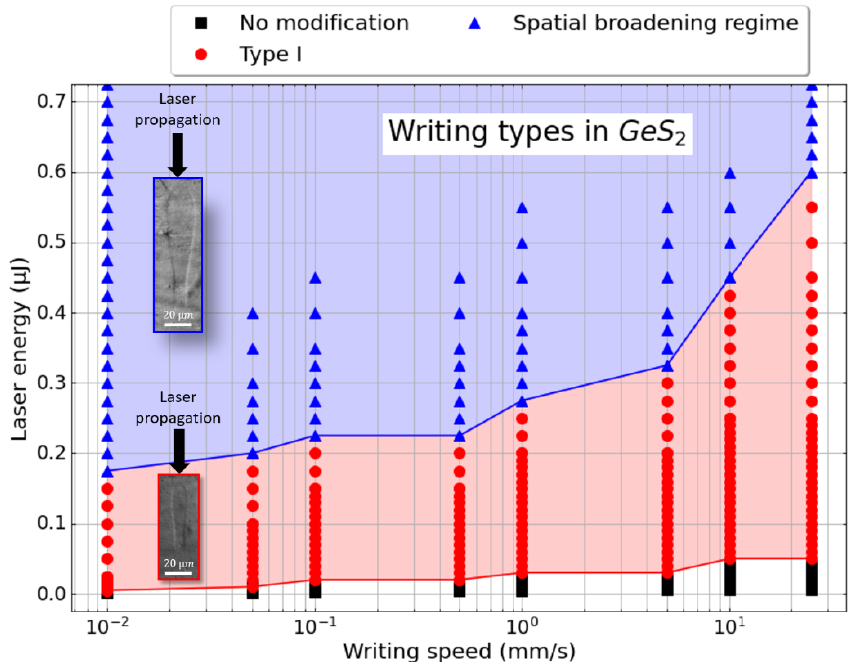
Figure 6. Processing windows in the 75 ( GeS 2 ) − 15 ( In 2 S 3 ) − 10 ( CsCl ) as a function of laser energy and writing speed. These values were found with a pulse duration of 800 fs and a repetition rate of 100 kHz. In the blue area: an optical microscope image of a laser track cross-section in the spatial broadening regime. In the red area: optical microscope image of a Type I cross-section.